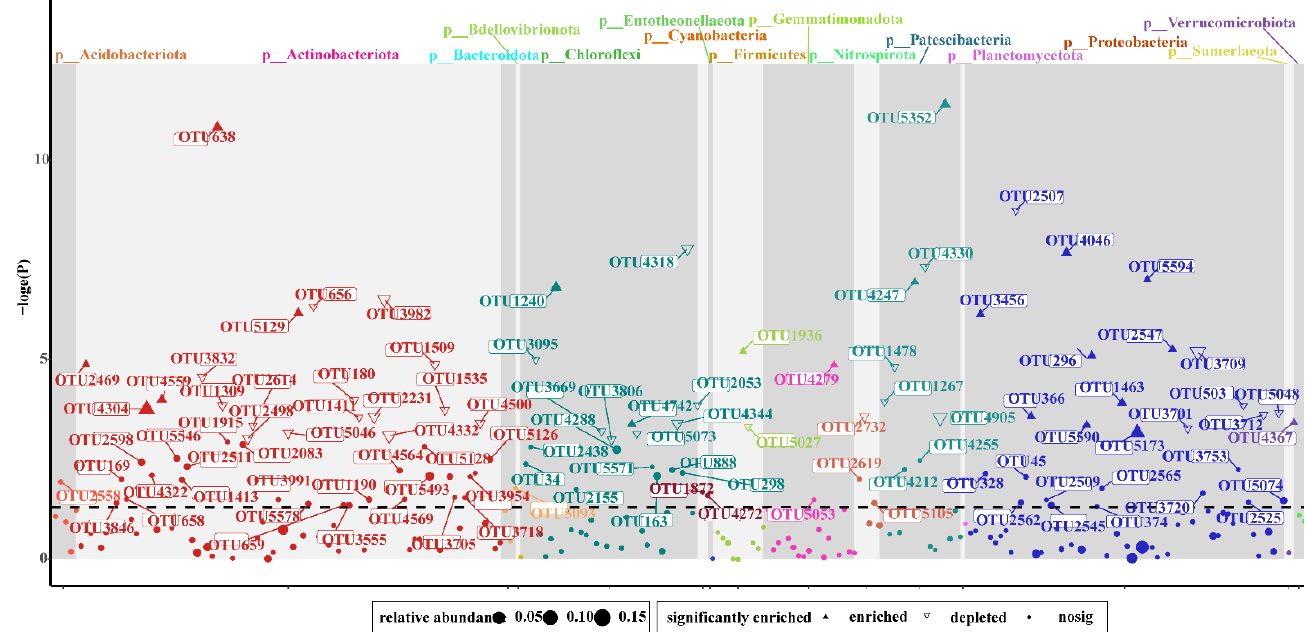
Figure 7. Manhattan plots showing OTUs with significant differences in relative abundance in CRU and CRU+FA treatments in Mod 3. Each triangle or circle represents an individual OTU. Upward solid triangles or downward hollow triangles represent OTUs enriched or depleted, respectively, whereas circles represent OTUs that are not significantly enriched or depleted. The dashed line corresponds to the false discovery rate-corrected threshold p -value for significance ( α = 0.05). The color of each dot represents the taxonomic affiliation of the OTU (phylum level) and the size corresponds to its relative abundance in the